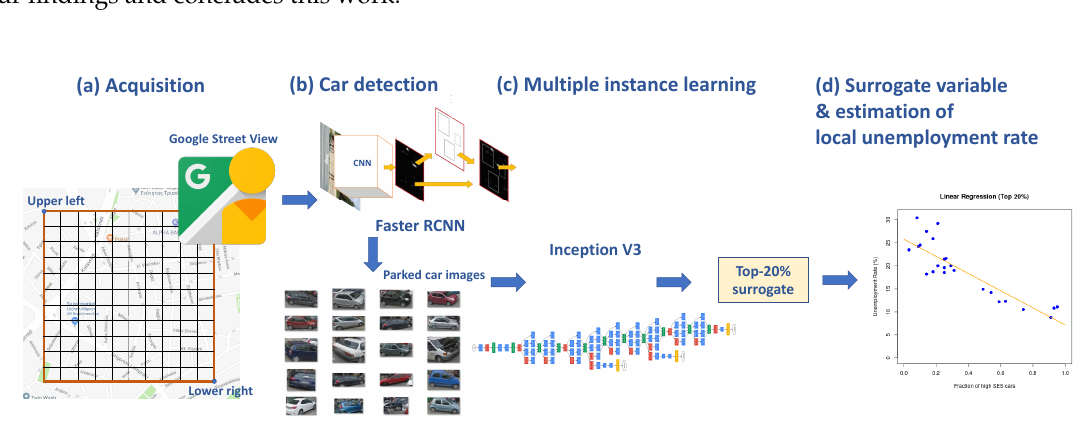
Figure 1. Illustration summarizing the proposed method. Step ( a ): The regions of interest are defined via Geographical Information System (GIS) data and sampling in a regular grid is used to retrieve side-view images from the streets inside the region. Step ( b ): Faster R-CNN [17] is used to detect parked cars. Step ( c ): During training, images of detected cars are used to train an Inception V3 model [18] using multiple instance learning where each car is classified as “high” or “low” SES based on the region it was observed in (same label for all cars of a single municipality). During testing, the model is used for car classification. Step ( d ): The model output is used to compute aggregate metrics which enable us to accurately estimate indicators of socioeconomic status, such as local unemployment rate, with simple linear models. The proposed method can be used to estimate SES at arbitrary geographical resolution, including at the local neighborhood level. Car images, maps and logo c (cid:13)